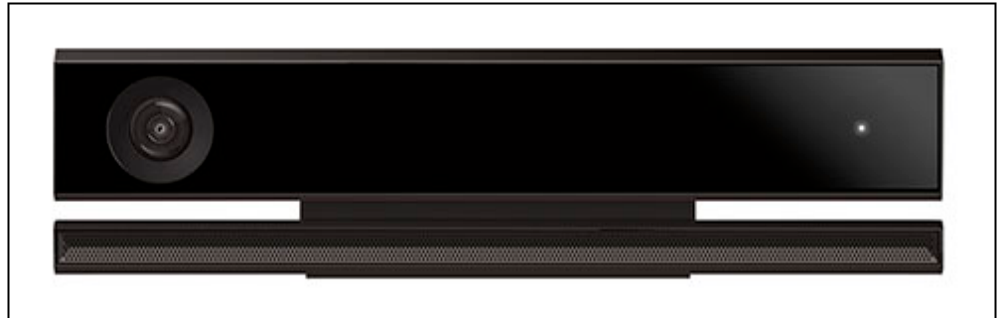
Figure 1. Microsoft Kinect v2 sensor.